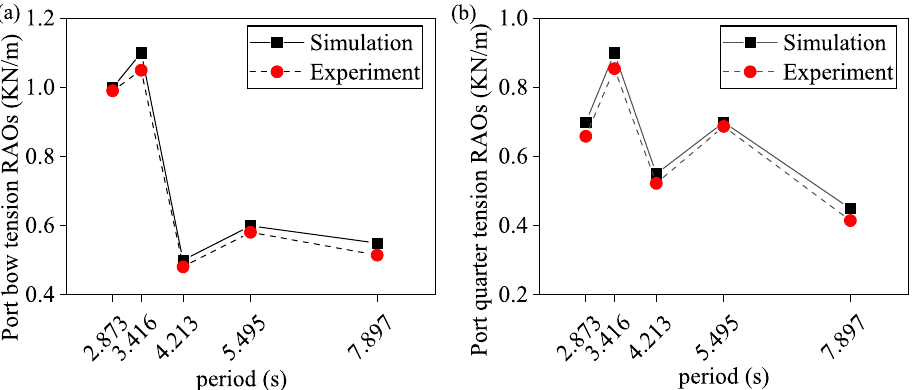
Figure 12. Comparison of mooring tension RAOs between measurements and simulations in port bow and port quarter lines: ( a ) the port bow tension RAOs; ( b ) the port quarter tension RAOs.